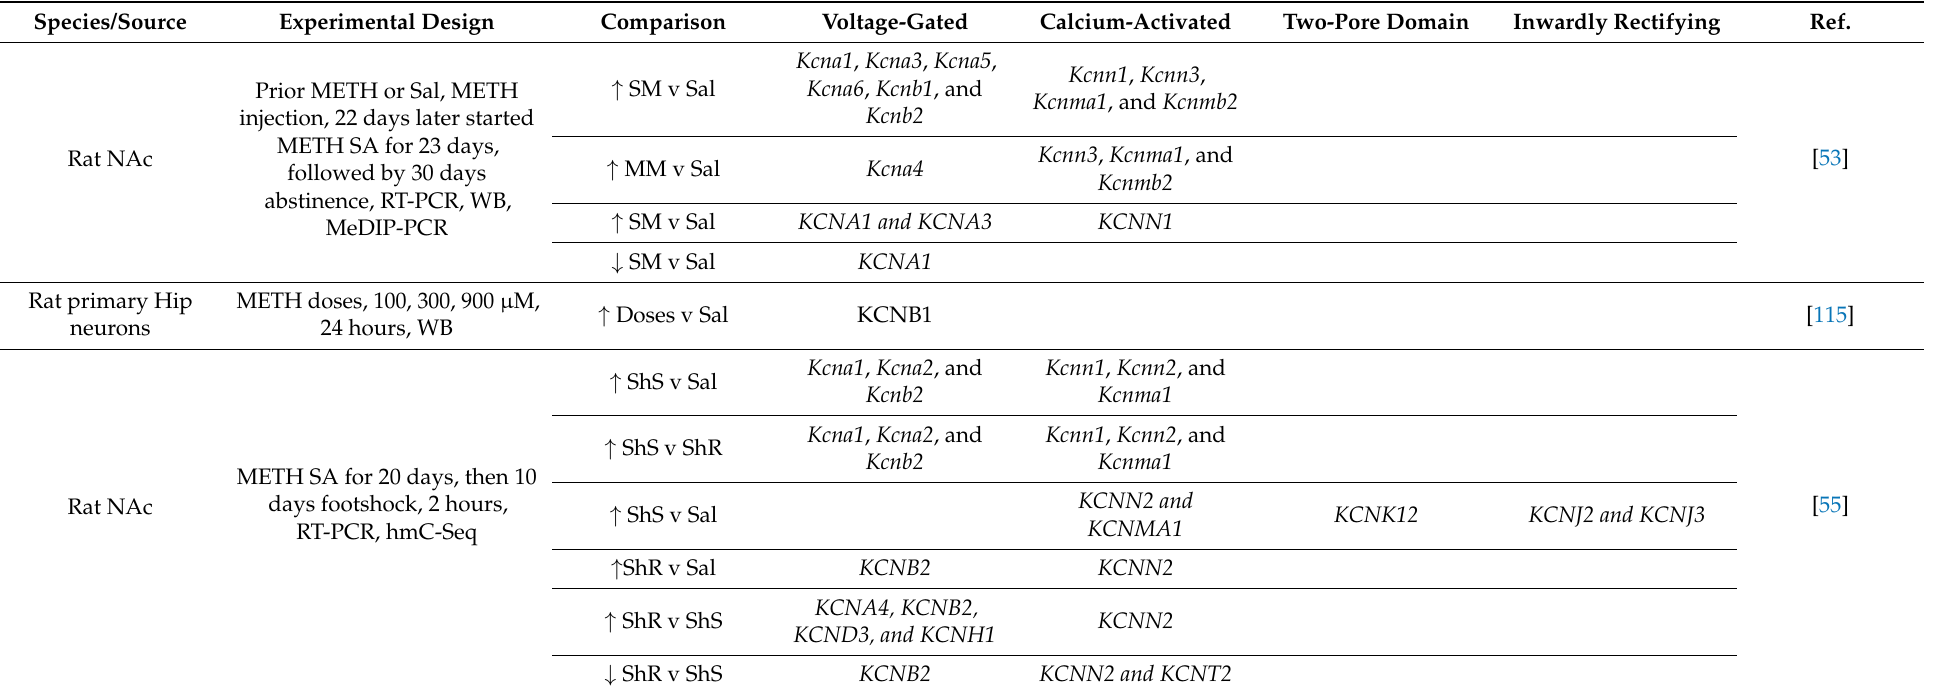
Table 4. Potassium Channels Effected by